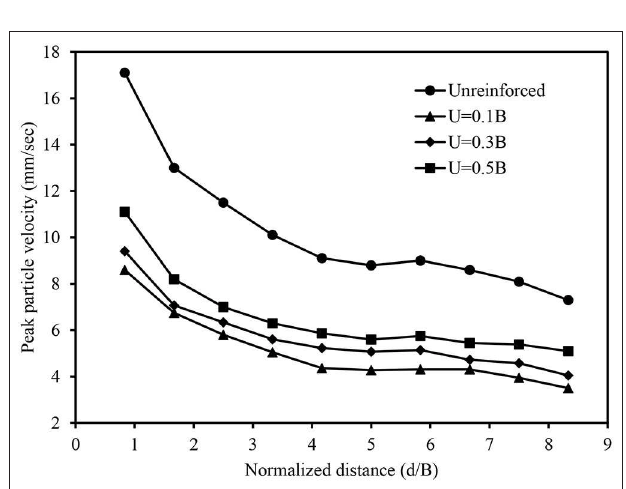
FIGURE 5 | Change in PPV with the normalized distance and depth of placement of geocell.